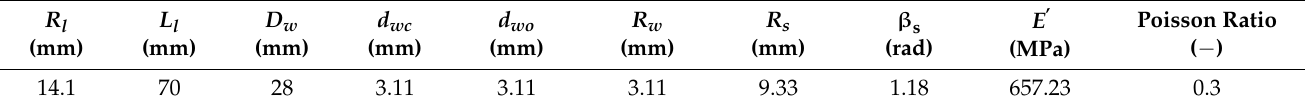
Table 1. Parameters for solving the friction lining-wire rope dry contact.